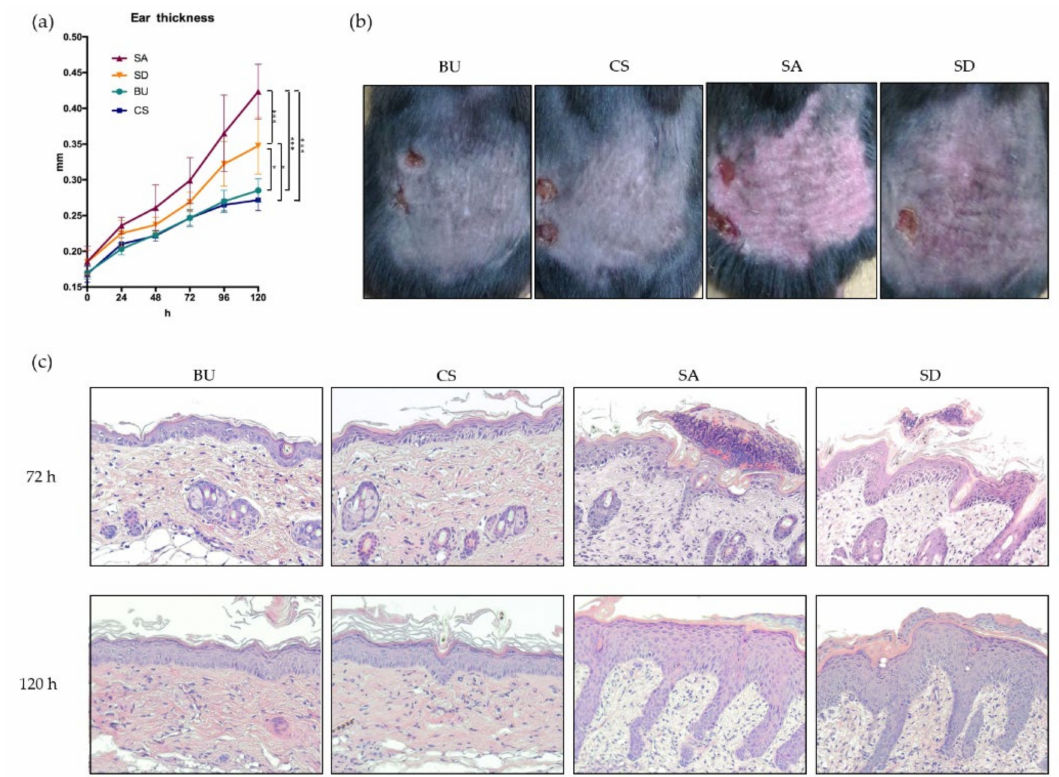
Figure 3. Stapylococcus aureus (SA)- and Streptococcus danieliae (SD)-administrated mice exhibit aggravated inflammation of the skin in an imiquimod-induced dermatitis model. ( a ) Phenotypically, SA- and SD-fed mice have significantly thicker ears compared with Bacteroides uniformis (BU)- and Clostridum scindens (CS)-fed mice over time. * p < 0.05, *** p < 0.001. ( b ) SA- and SD-fed mice exhibit stronger erythema, scales, and hyperplasia compared with BU- and CS-fed mice. ( c ) Hematoxylin and eosin staining of the back skin shows thickened epidermis, hyperkeratosis, spongiosis, micro abscess, and increased infiltration of mixed inflammatory cells in SA- and SD-fed mice compared with BU- and CS-fed mice. Original magnification ×